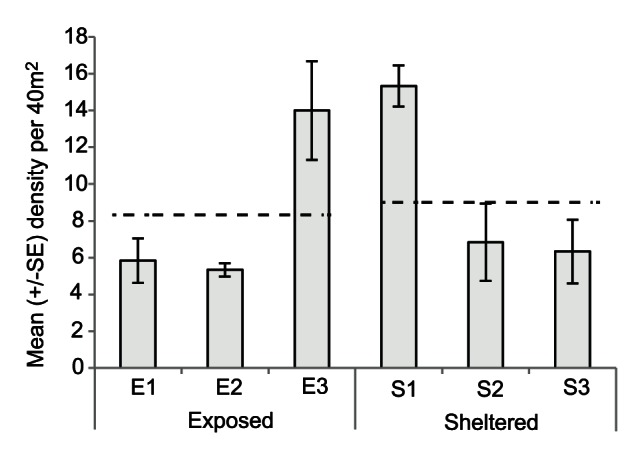
Mean density (± S.E.) of Acropora spp. at exposed and sheltered sites in the Palm Islands after cyclone Yasi (2011).Dashed lines indicate mean densities across the three sites in each exposure.